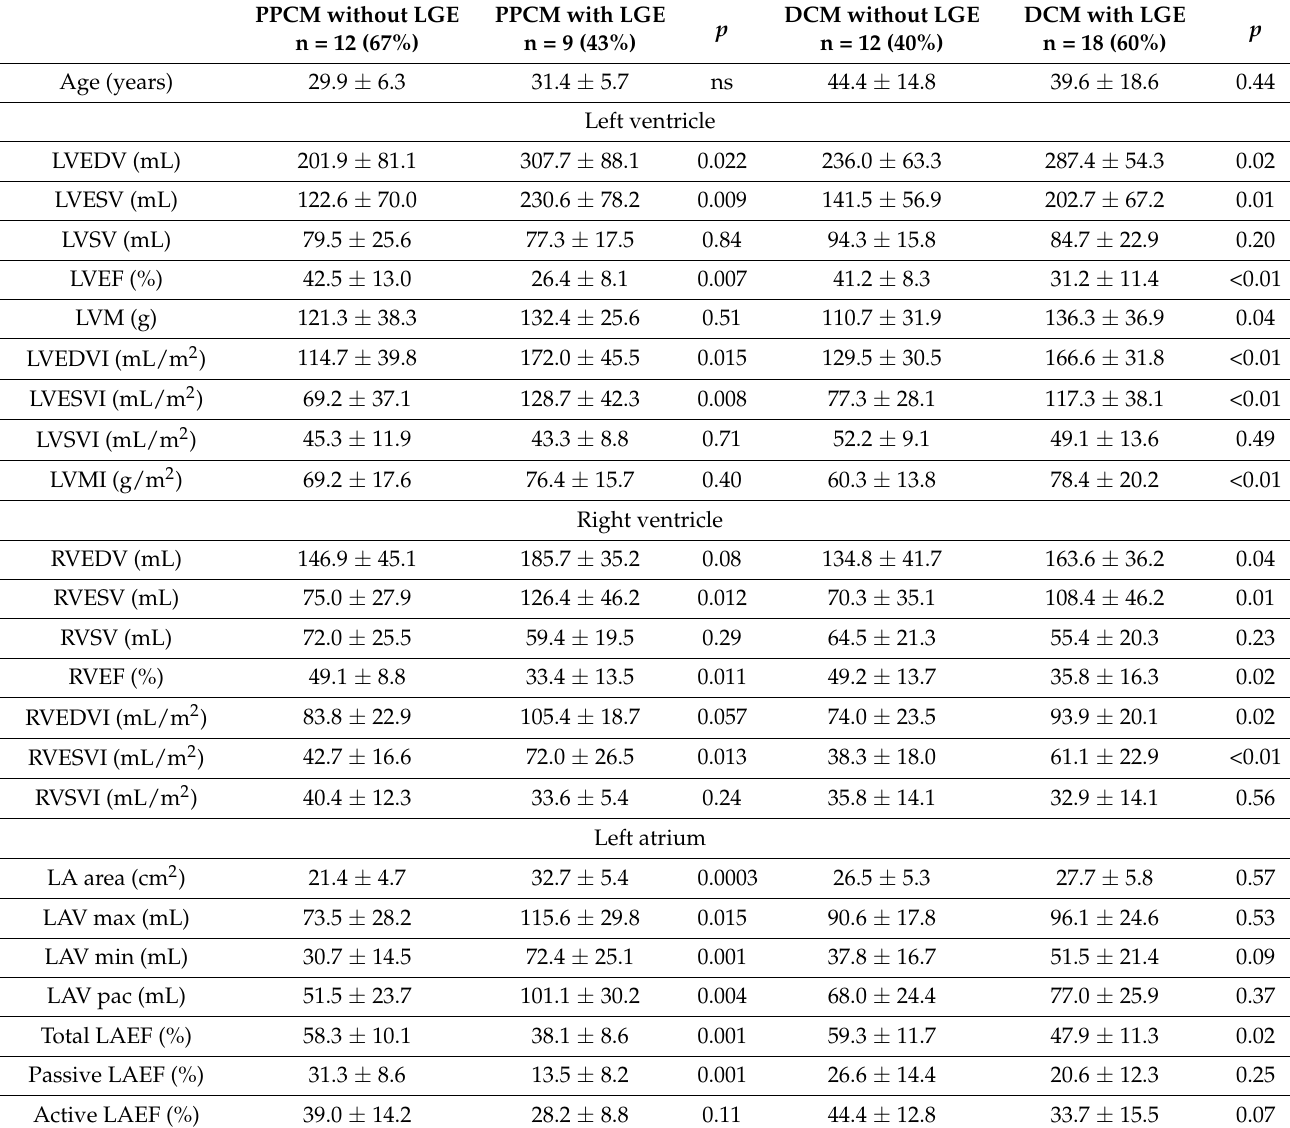
Table 3. Volumetric and functional CMR characteristics between female patients with PPCM and DCM with and without LGE. PPCM without